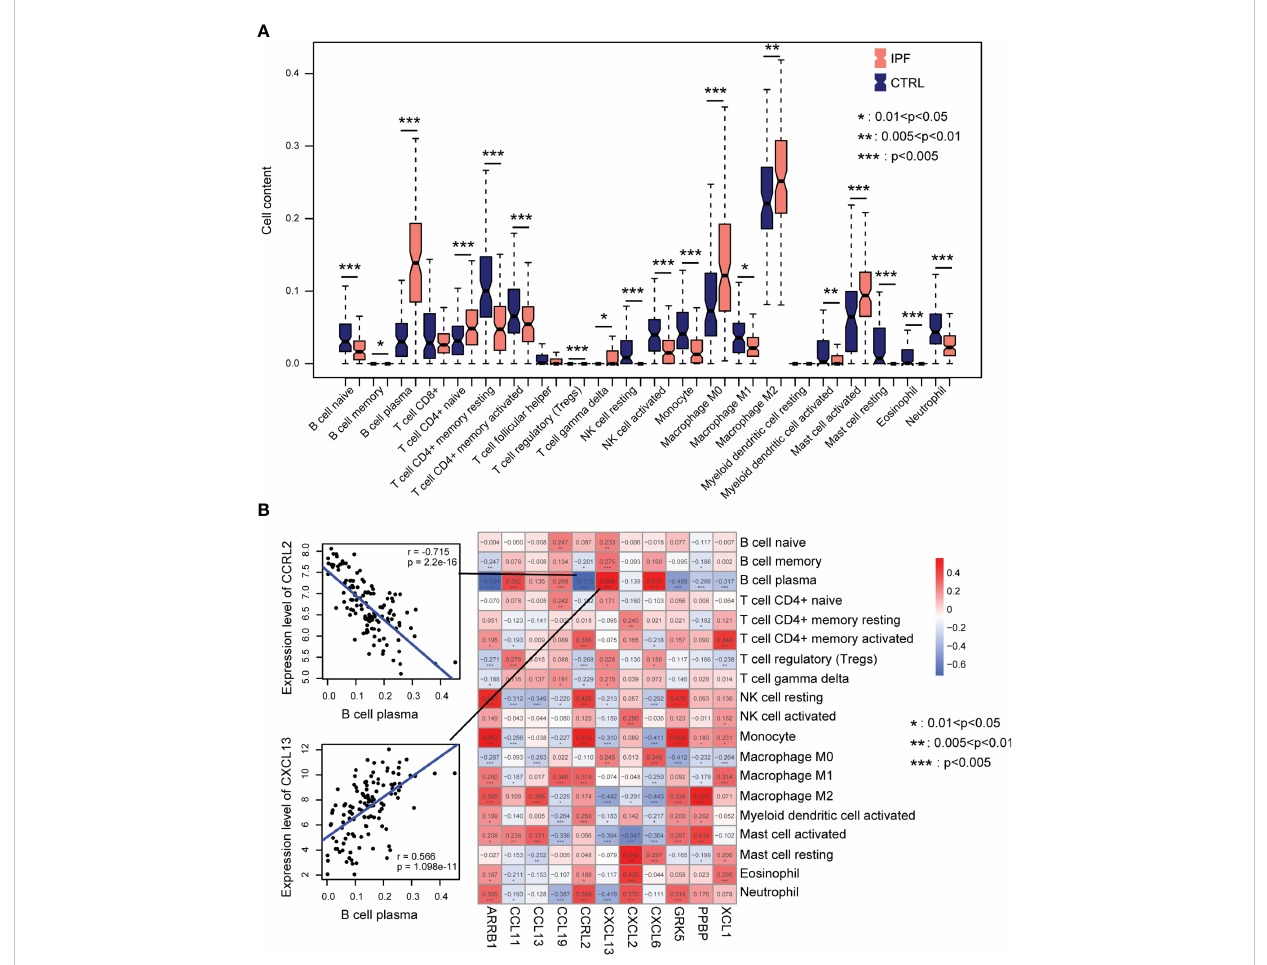
FIGURE 5 Immune cell in fi ltration. (A) Distribution of immune cells in normal and IPF lung tissue. (B) Correlation between eleven CR-DEGs expression levels and levels of in fi ltration immune